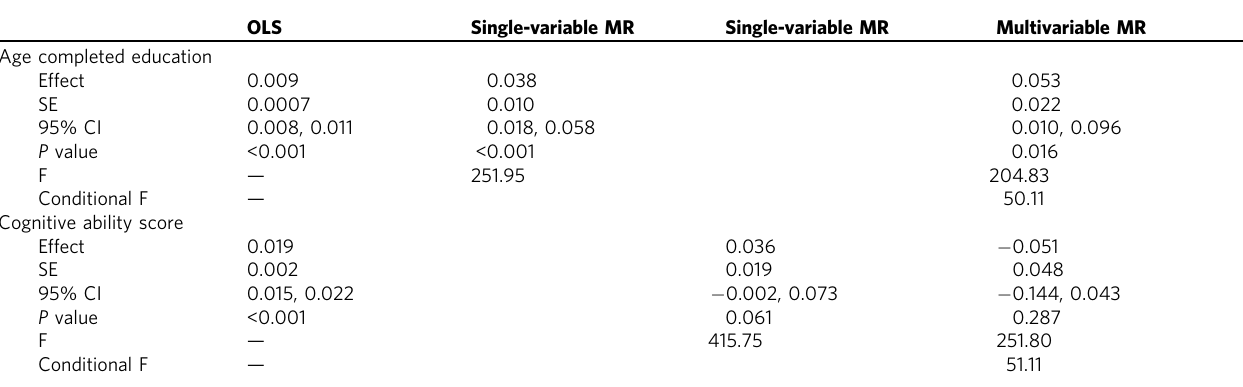
Table 3 The effect of education and general cognitive ability on smoking cessation OLS